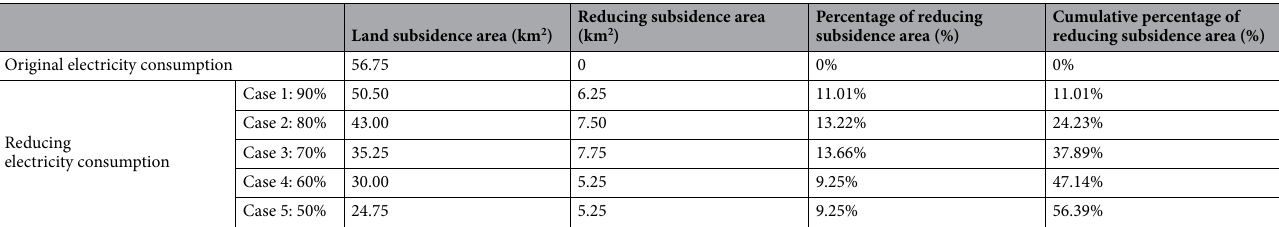
Table 4. Reduction of the critical subsidence area.